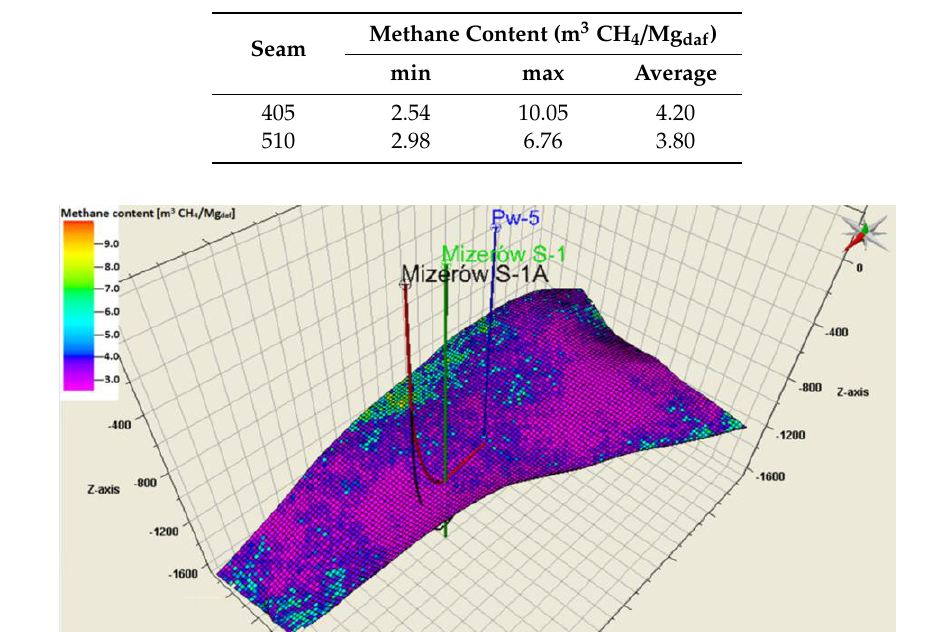
Table 2. Methane content in coal seams 405 and 510.